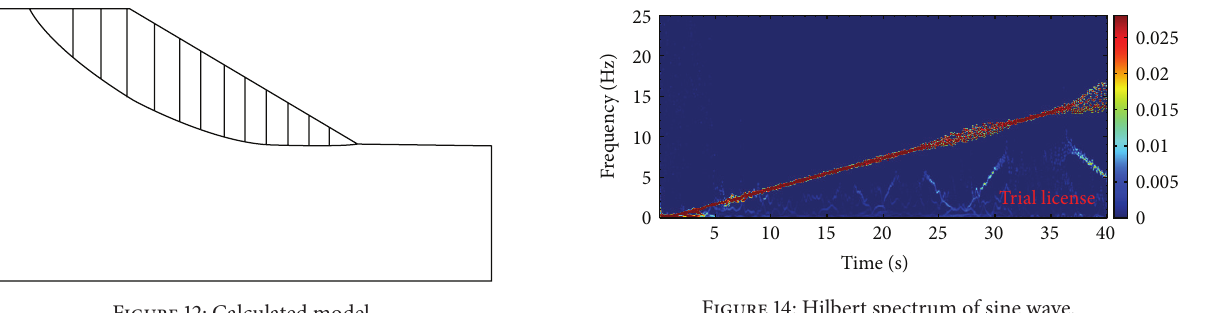
Figure 12: Calculated model.